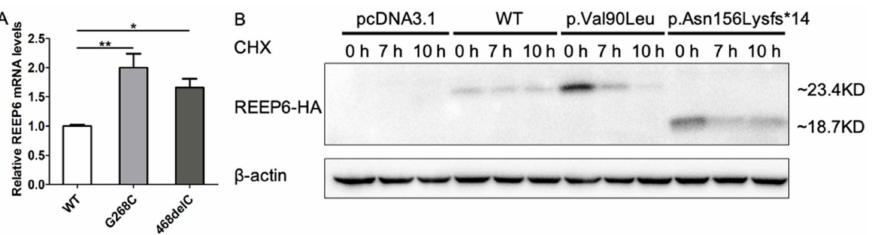
Figure 5. ( A ) The mRNA expression of REEP6 detected by real-time PCR. Relative expression was normalized to β -actin (* p < 0.05, ** p < 0.01, n = 3). WT = wild type. ( B ) Protein stability evaluated by Western blot. β -actin was used as loading control.